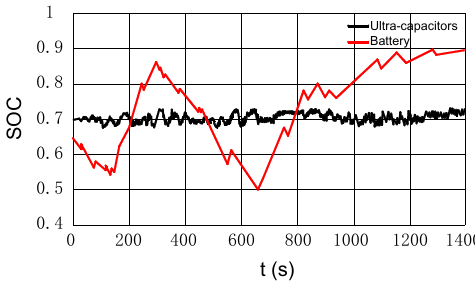
Figure 20. SOC of the battery and ultra-capacitors.